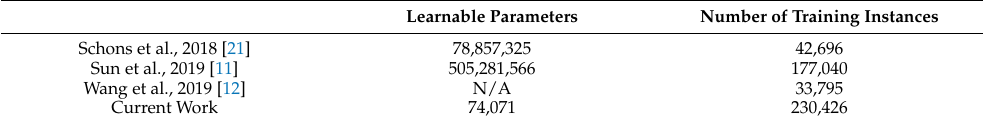
Table 12. Learnable Parameters and Data Size.